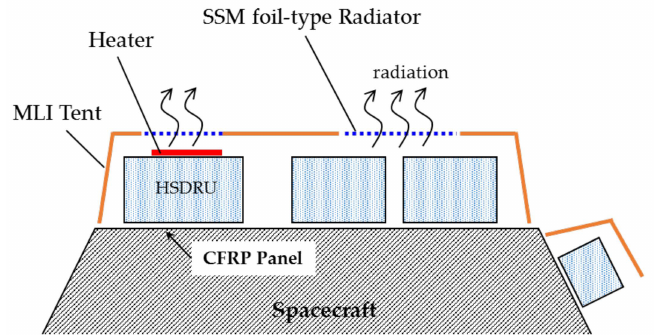
Figure 2. Schematic of thermal control strategy of HSDRU on spacecraft.